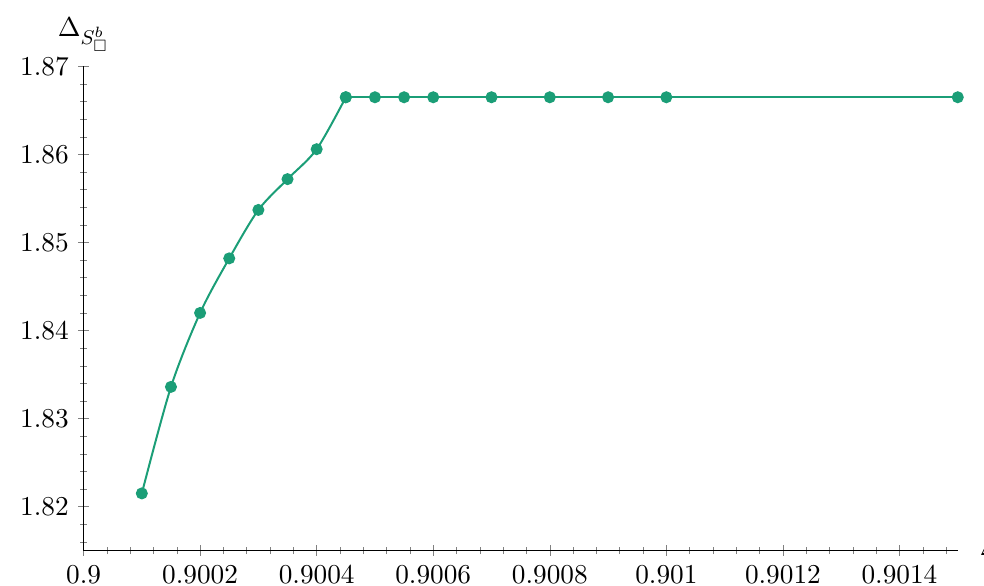
Figure 17 . The dimension of S b the bound of (cid:12)gure 16. The markers indicate the points at which we have computed the spectrum.